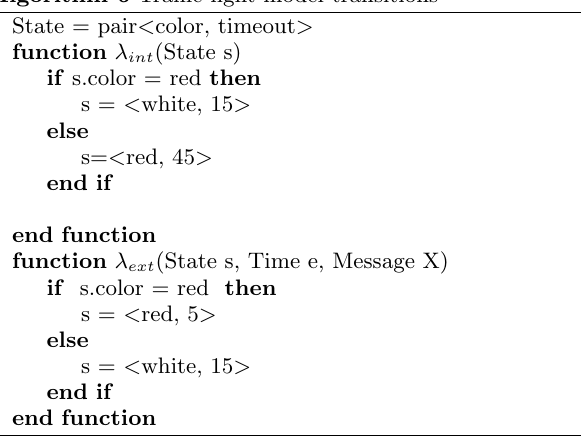
Algorithm 6 Traffic light model